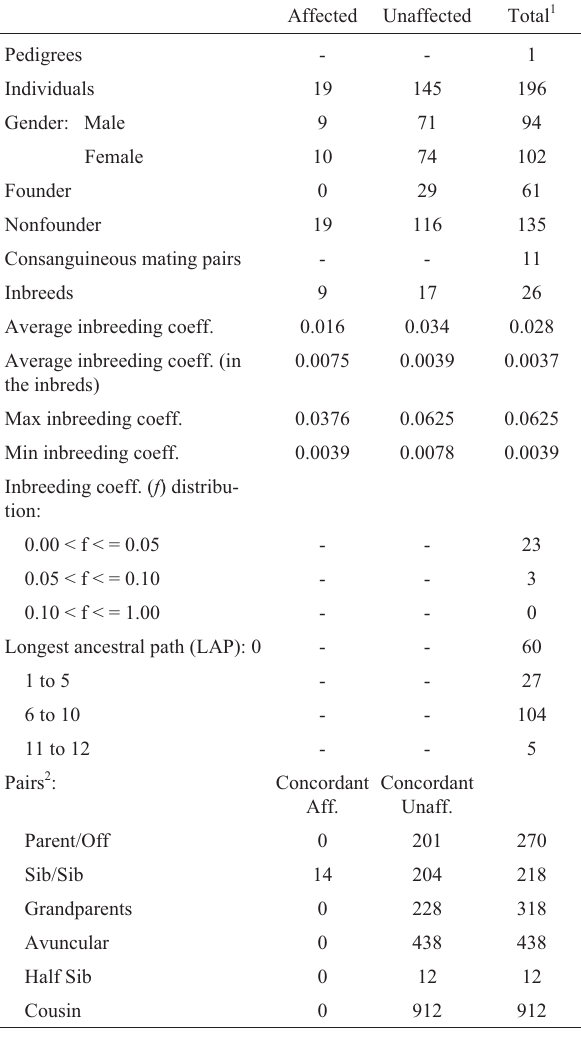
Table 3 - Analysis of pedigree structure and inbreeding of a subpedigree with 196 individuals from the Aicuña research project